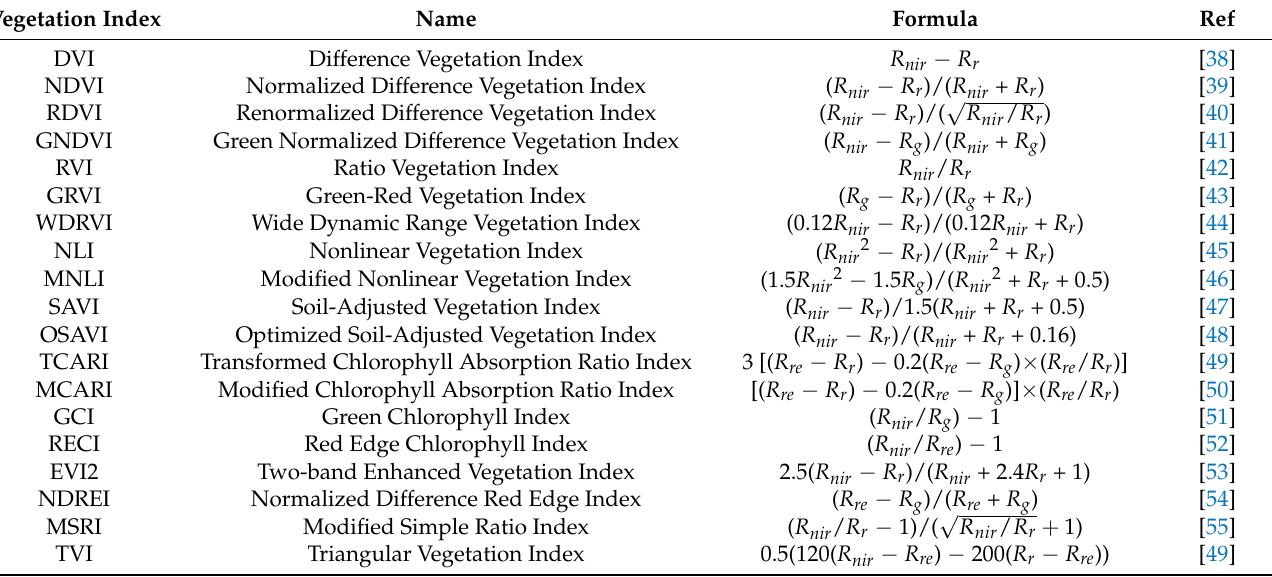
Table 2. Vegetation Indices used in this